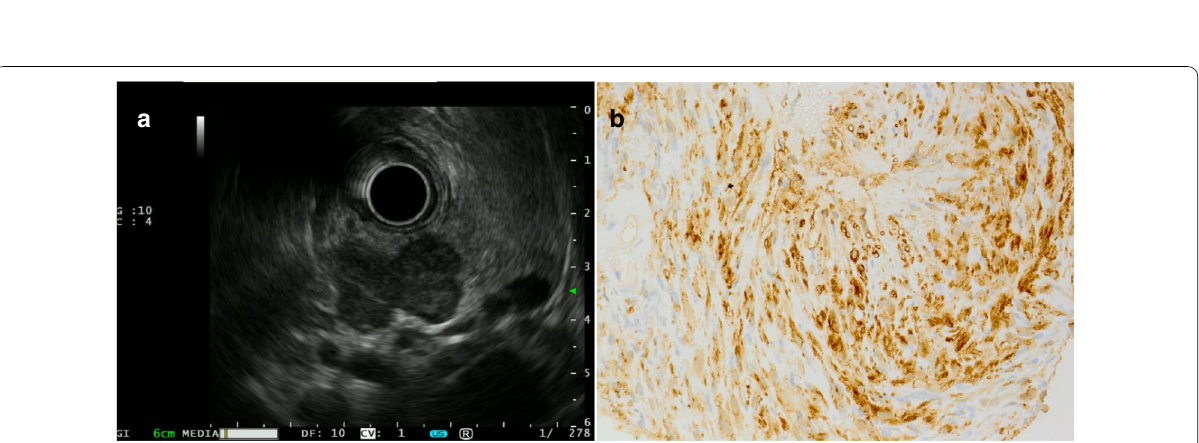
Fig. 3 Endoscopic ultrasonography (EUS) showed a lobulated, low-echoic mass with a clear boundary at the pancreatic body and tail ( a ). The tumor cells in the EUS-fine needle biopsy specimens were spindle shaped and diffusely immunopositive for S-100 ( b